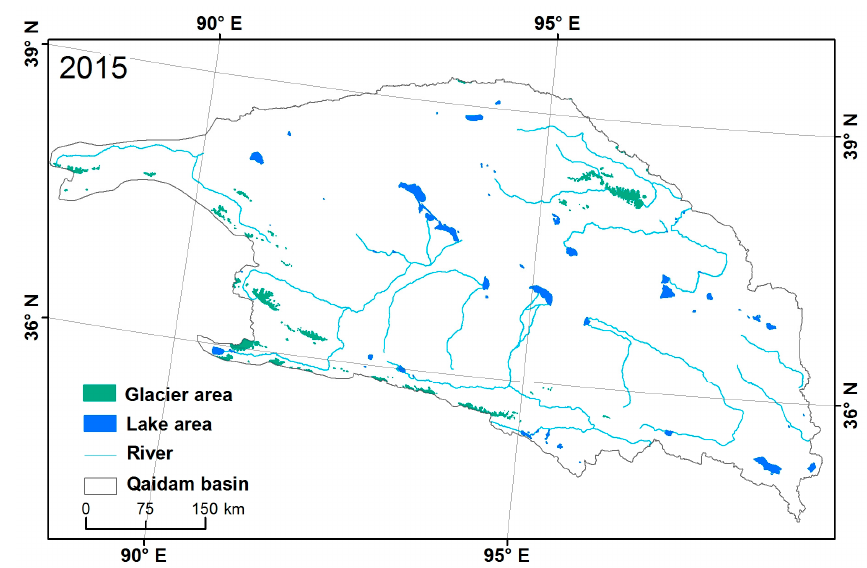
Figure 7. Spatial distribution of glaciers in the Qaidam Basin (QB) in 2015.